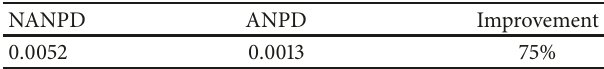
PD (ANPD) controller and nonaugmented nonlinear PD (NANPD) controller. The assessment of controllers for